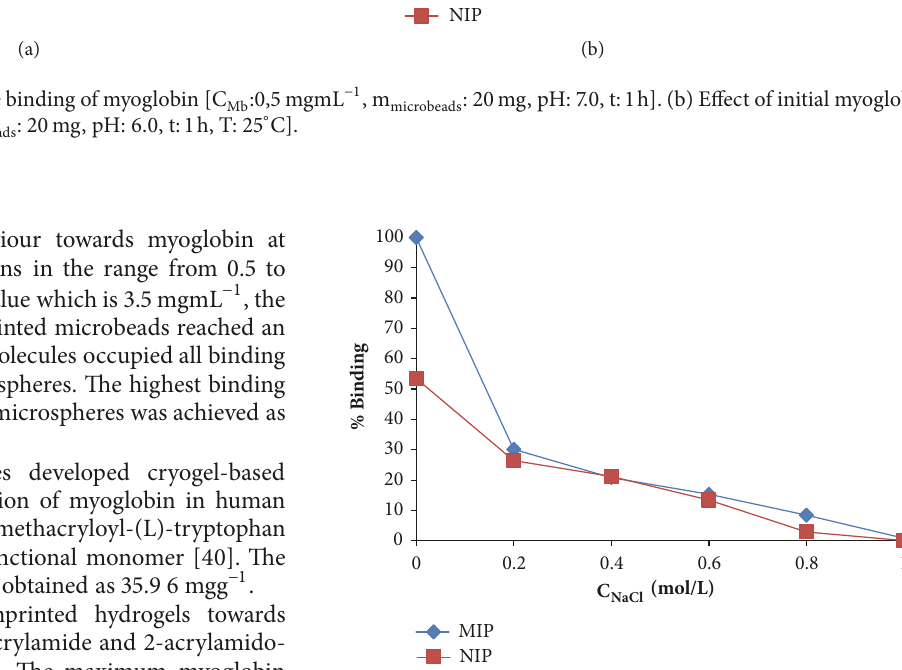
Figure 4: (a) The time effect on the binding of myoglobin [C Mb :0,5 mgmL −1 , m microbeads : 20mg, pH: 7.0, t: 1 h]. (b) Effect of initial myoglobin concentration on binding [m microbeads : 20mg, pH: 6.0, t: 1 h, T: 25 ∘ C].